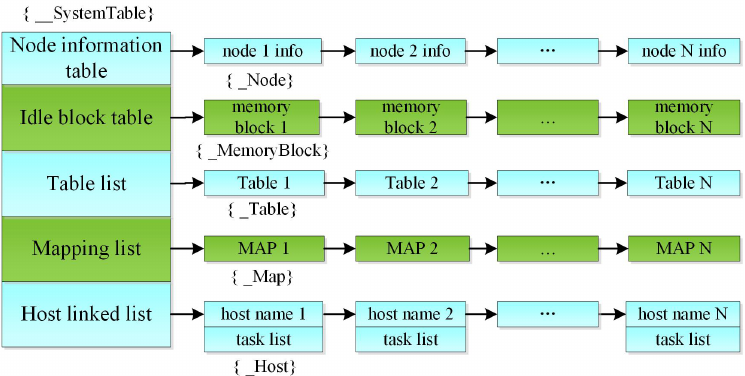
Figure 8. Design of the kernel data